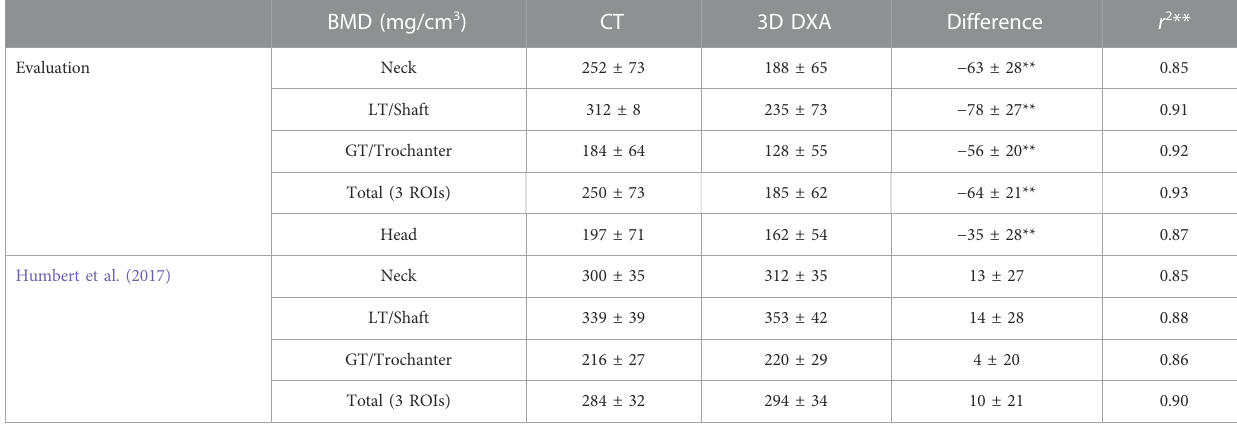
TABLE3MeanandstandarddeviationoftheintegralBMDresults(mg/cm 3 ).Thedensitydifferencesandcorrelationcoef fi cientsassociatedwith p -values < 0.01are marked with two stars. The remaining differences were associated with p -values > 0.05. LT and GT stand for lesser and greater trochanter, respectively, and were named shaft and trochanter by Humbert et al. (2017).